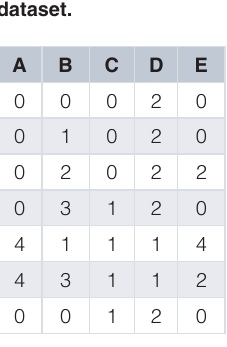
Table 1. Example